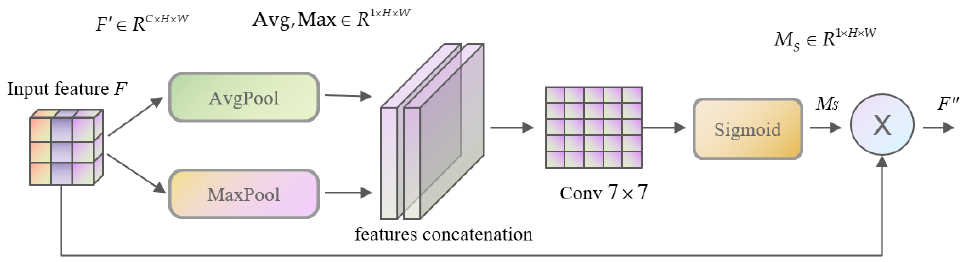
Figure 6. Structure of the spatial attention model.